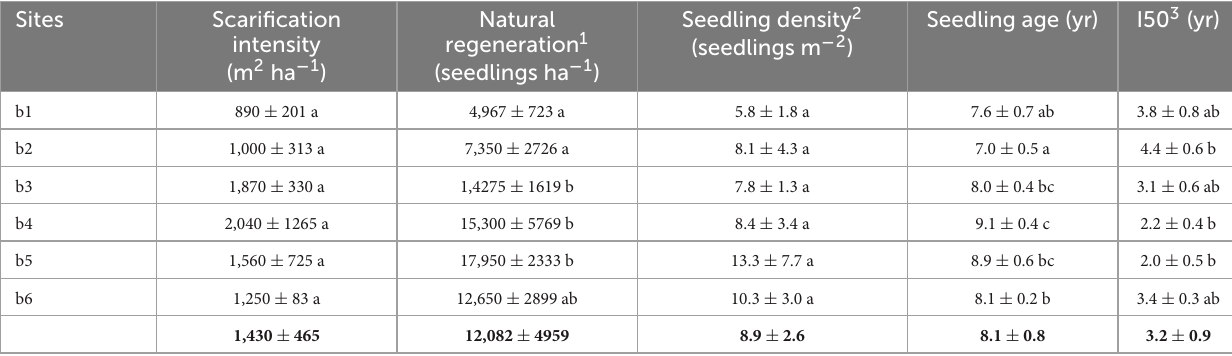
TABLE 2 Scarification intensity, natural regeneration, seedling density, mean seedling age and seedling establishment index (I50) at the six study lichen woodlands.